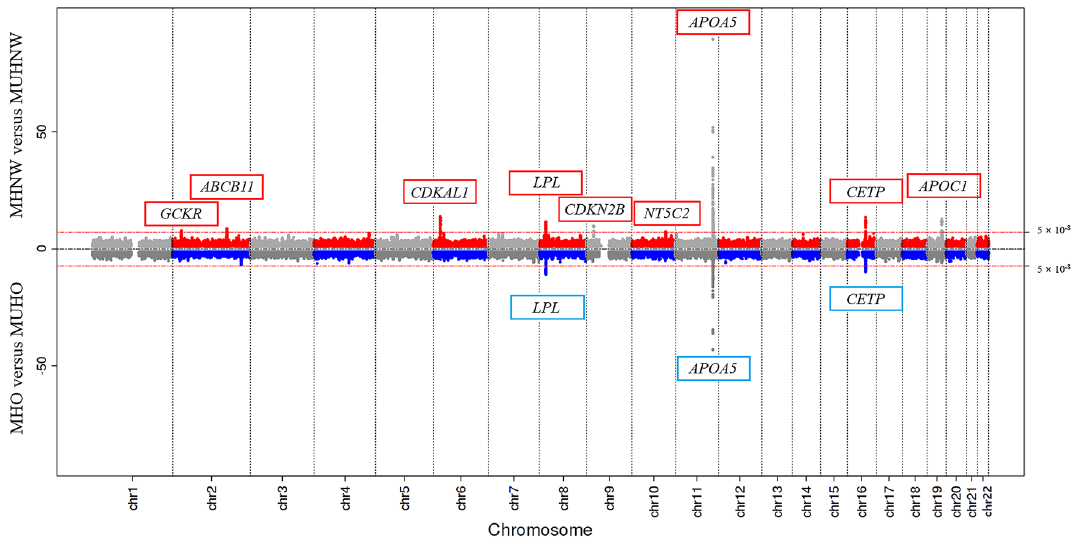
Figure 1. Miami plot of the GWASs for model 1 (MHNW versus MUHNW) and model 2 (MHO versus MUHO). SNP locations are plotted on the x-axis according to their chromosomal position. The −log 10 ( p - values) derived from the logistic regression analysis are plotted on the y-axis. The p -values were adjusted for age, sex, exercise status, smoking status, alcohol intake, body mass index, and PC1 and PC2. The horizontal red line indicates the formal threshold for genome-wide significance at p = 5.00 × 10 −8 . GWASs, genome-wide association studies; MHNW, metabolically healthy normal weight; MUHNW, metabolically unhealthy normal weight; MHO, metabolically healthy obese; MUHO, metabolically unhealthy obese; PC, principle component; SNP, single-nucleotide polymorphism. The figure was generated using EasyStrata version 8.6 (http://www.genep i-regen sburg .de/easys trata